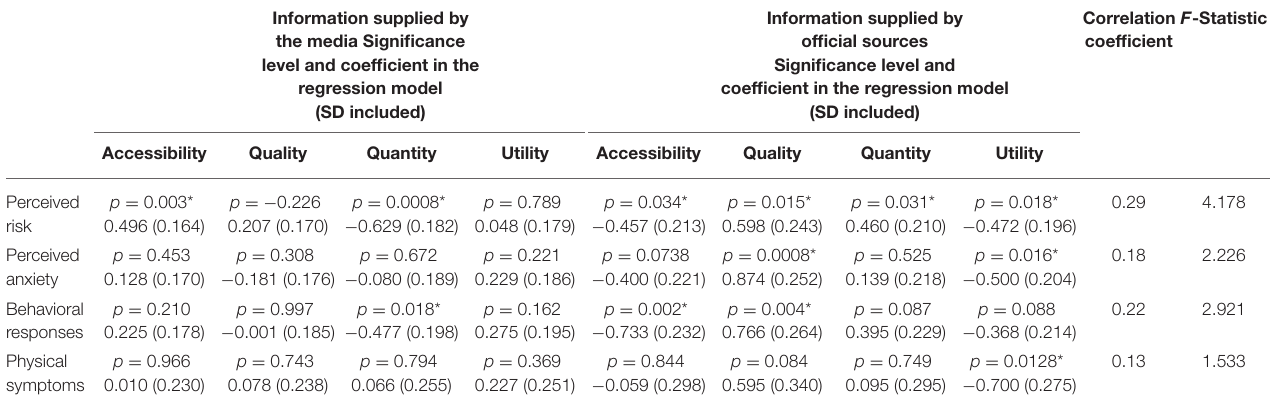
TABLE 5 | Regression